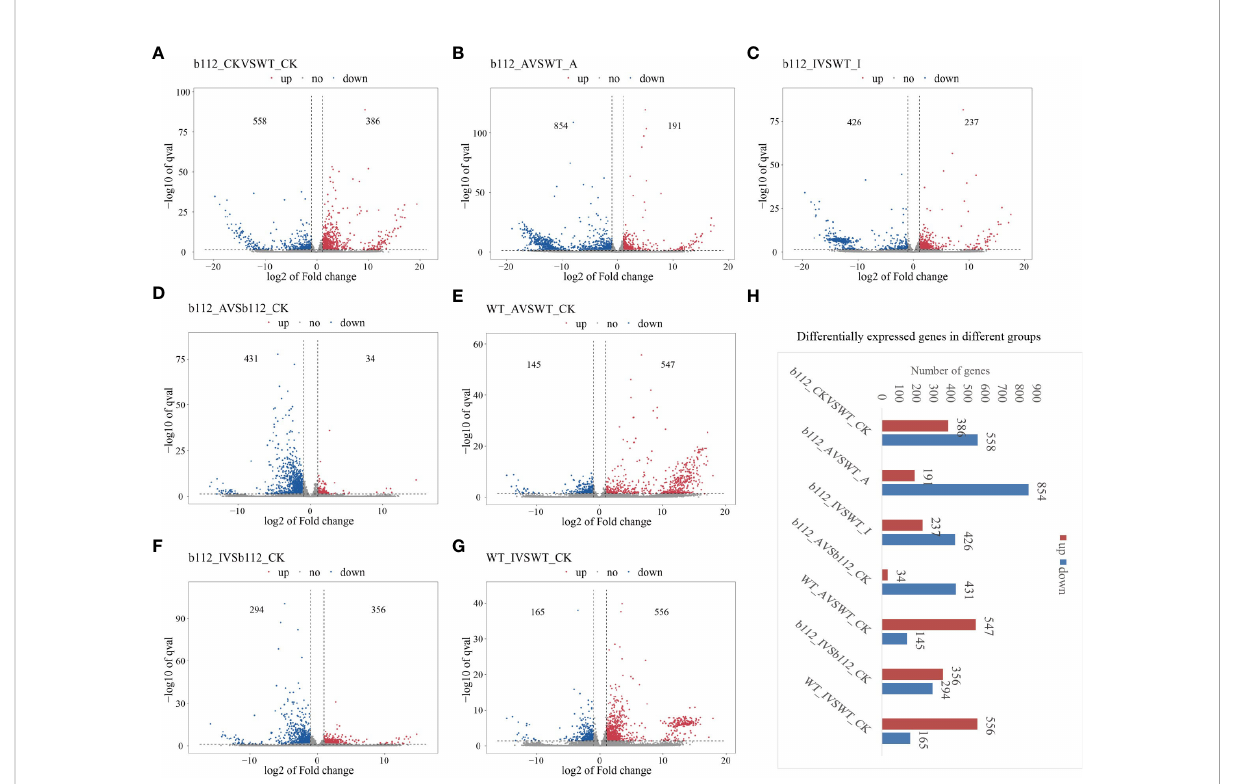
FIGURE 4 DEGs between bhlh112 and the wild-type. (A) Number of DEGs of bhlh112 and B73 under the control treatment; (B) Number of DEGs of bhlh112 and B73 under 10 µmol·L -1 exogenous ABA treatment; (C) Number of DEGs of bhlh112 and B73 under 100 µmol·L -1 exogenous IAA treatment; (D) Number of DEGs of bhlh112 under 0 µmol·L -1 and 10 µmol·L -1 exogenous ABA treatment; (E) Number of DEGs of B73 under 0 µmol·L -1 and 10 µmol·L -1 exogenous ABA treatment; (F) Number of DEGs of bhlh112 under 0 µmol·L -1 and 100 µmol·L -1 exogenous IAA treatment; (G) Number